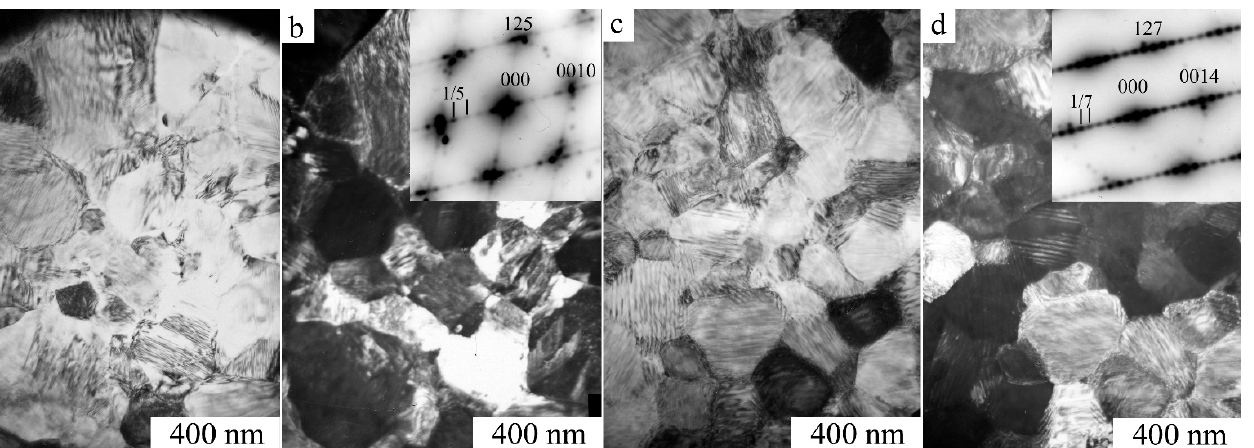
Figure 6. ( a , c ) Bright- and ( b , d ) dark-field TEM images of the microstructure and corresponding SAED patterns (in the inserts) of the Ni 50 Mn 28.5 Ga 21.5 alloy subjected to HPT at 5 GPa and five revo- lutions and subsequent annealing at 623 K for 10 min. Observations were performed at ( a , b ) RT and ( c , d ) 120 K.